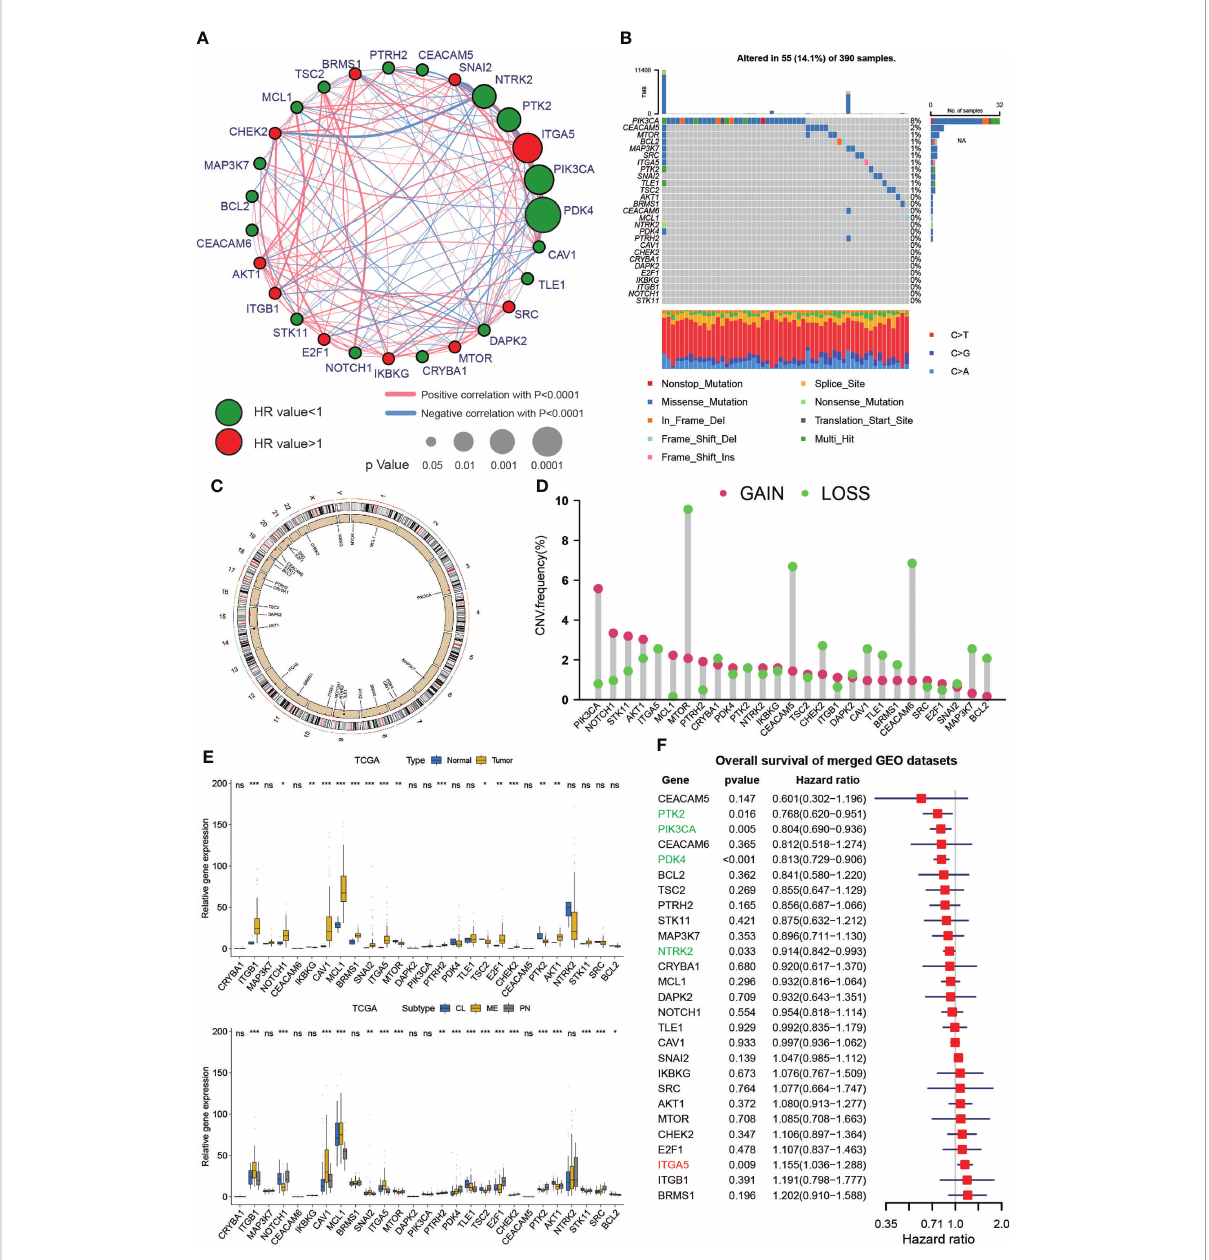
FIGURE 1 Genetic variations and expression of anoikis-related genes in GBM. (A) Network diagram showing the interaction of 27 anoikis-related genes in GBM. The size of the circles indicates the p-value of each gene on survival prognosis. Red represents risk factors, and green dots represent favorable factors. The thickness of the lines indicates the correlation values between genes. The red and blue lines represent positive and negative correlations of gene regulation, respectively. (B) Mutation prevalence of 27 anoikis-related genes in GBM. (C) The localization of the 27 anoikis-related genes on TCGA-GBM 23 chromosomes. (D) CNV variation frequency of 27 anoikis-related genes in TCGA-GBM. (E) Differences in expression of 27 anoikis-related genes between normal and GBM tumors and in different TCGA GBM subtypes. * means P< 0.05; ** means P< 0.01; *** means P< 0.001; ns means P > 0.05. (F) The effect of 27 anoikis-related genes on the overall survival of merged GEO datasets. Green represents gene downregulation and red is gene